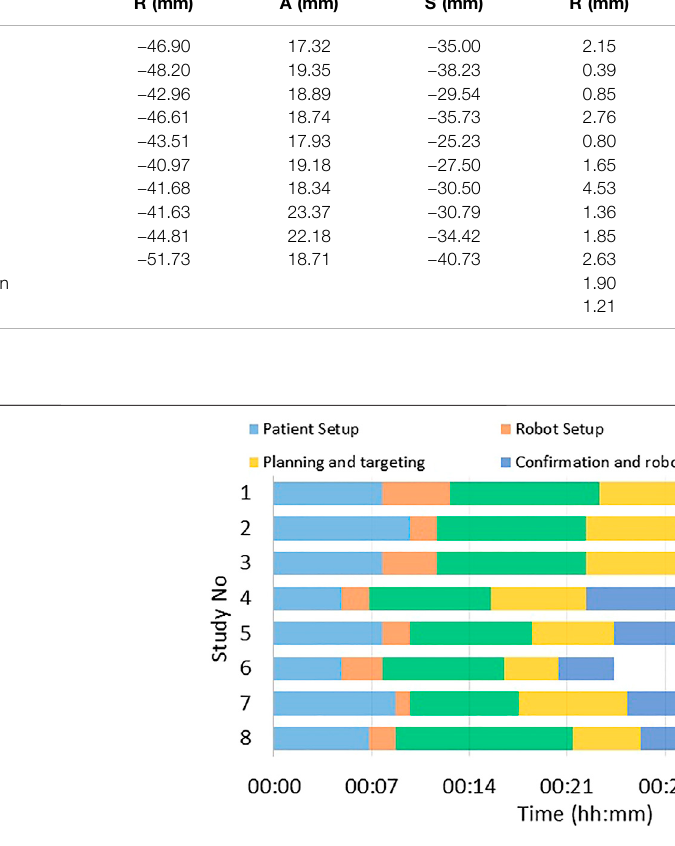
FIGURE 8 | Results from the clinical work fl ow studies showing duration for each of the work fl ow steps.